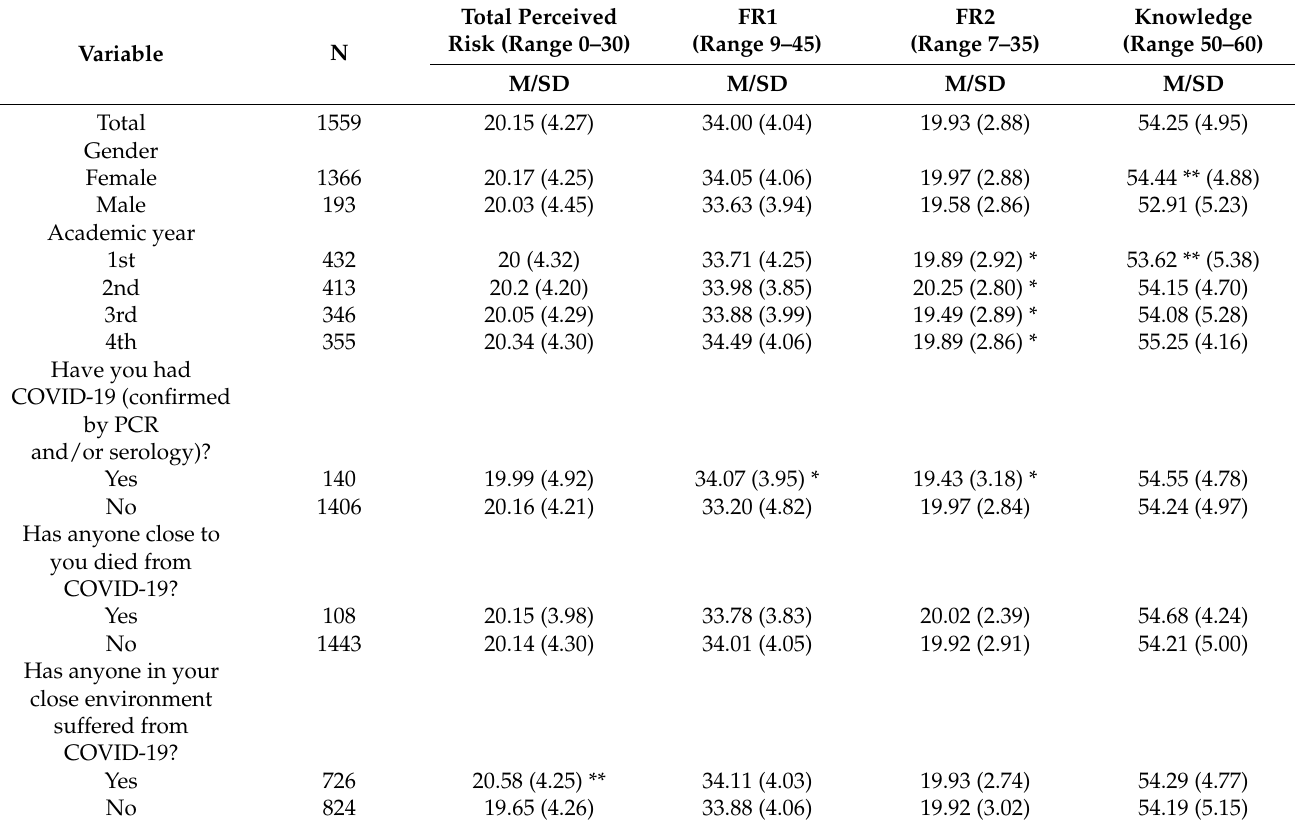
Table 2. Gender variables, academic year and having suffered COVID-19 by risk perception, risk factors and knowledge subscales (descriptive and differential